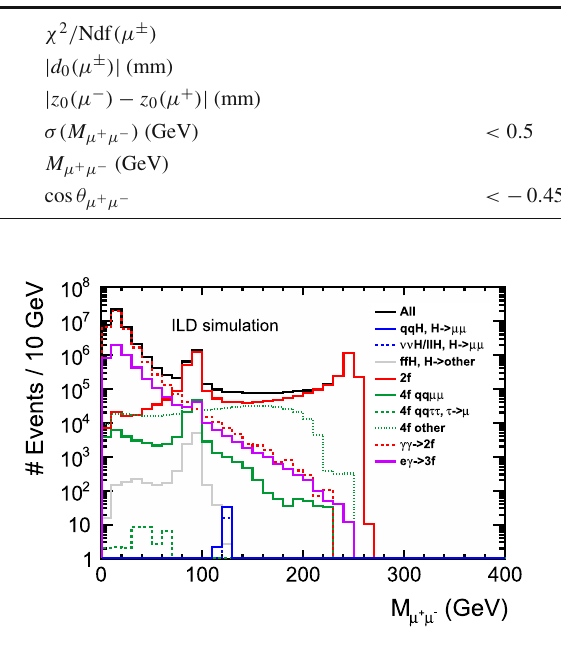
Fig. 4 The distribution of M μ + μ − before applying cut #5 (see Table 4) in qqH250-L. The solid blue histogram shows the signal